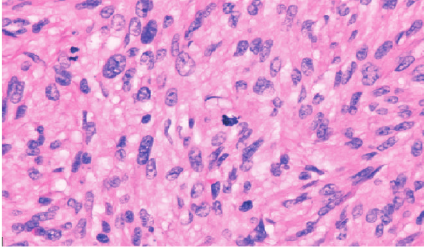
Figure 2: Spindle cells with typical cigar-shaped nuclei and abnor- mal mitotic figures.